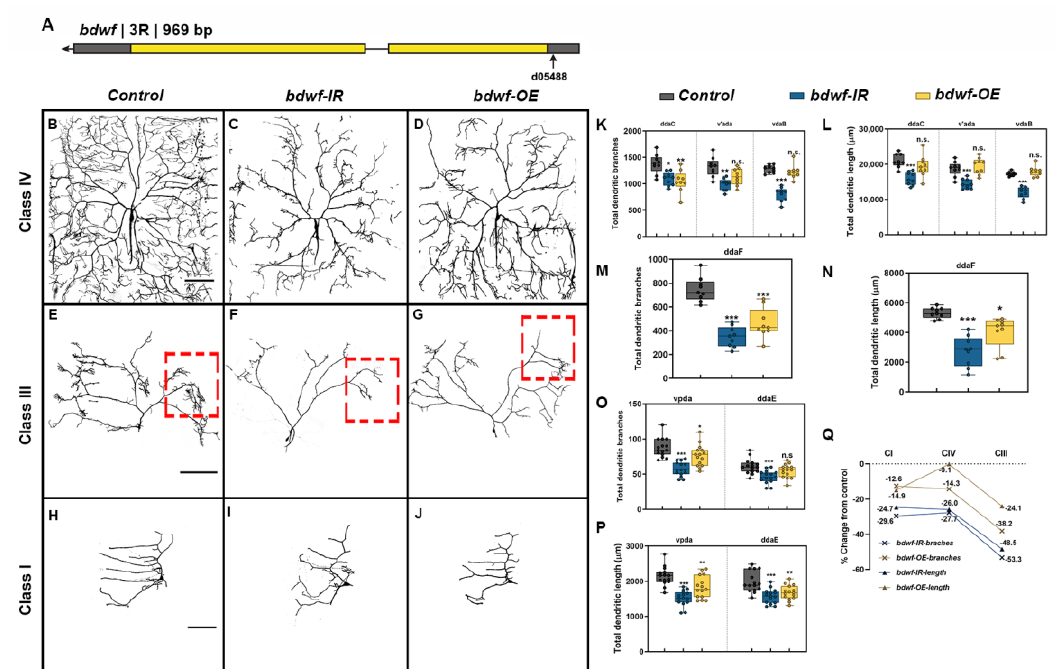
Figure 1. Optimal levels of bdwf are essential for proper dendrite morphogenesis . ( A ) Schematic diagram showing the bdwf gene and the location of the mutant allele used in the study. LOF and GOF result in strong and penetrant dendritic growth and branching defects in CIV ( B – D ), CIII ( E – G ), and CI md neurons ( H – J ). Scale bar, 50 µm. ( K – P ) Quantification of the total dendritic branches and total dendritic length are shown for CIV md neuron subtypes ( ddaC, v’ada, and vdaB) ( K , L ), CIII md neuron subtype (ddaF) ( M , N ) and CI md neuron subtypes (ddaE, vpda) ( O , P ). * p ≤ 0.05, ** p ≤ 0.01, *** p ≤ 0.001 , n.s.=not significant (One- way ANOVA with Dunnett’s multiple comparison test). Number of samples, n = 14 – 15 for CI, n = 9 for CIII and n = 8 – 9 for CIV. (Q) Total dendritic length and total dendritic branches for each condition are represented as percentage change from control. The dashed red boxes depicted in ( E,F,G ) correspond to the region displayed in Figure 2 ( A , B , C , respectively). Genotypes: ( B – D , K , L , Q ) Gal4 477 , UAS – mCD8::GFP/+; +/+ or Gal4 477 , UAS –